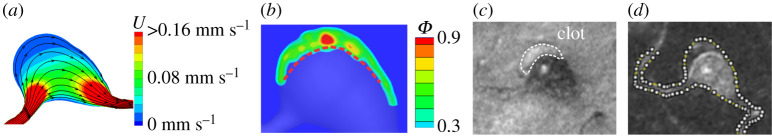
Comparison of the simulation results to the experimental observations. (a) Velocity field and streamlines in the cross-section of MA1 computed at an inlet velocity of U0 = 1.6 mm s−1. (b) The platelet aggregation inside the dilated lumen of MA1 at cycle 10 expressed in terms of the volume fraction ϕ. (c) AOSLO image of MA1, and (d) the corresponding perfusion map. The red dotted line in (b) signifies the boundary between the flowing blood and thrombus observed in (c). The white dotted line in (c) highlights the boundary of the thrombus. The white dotted line in (d) highlights the boundary of the MA1. (c,d) are adapted from [27].